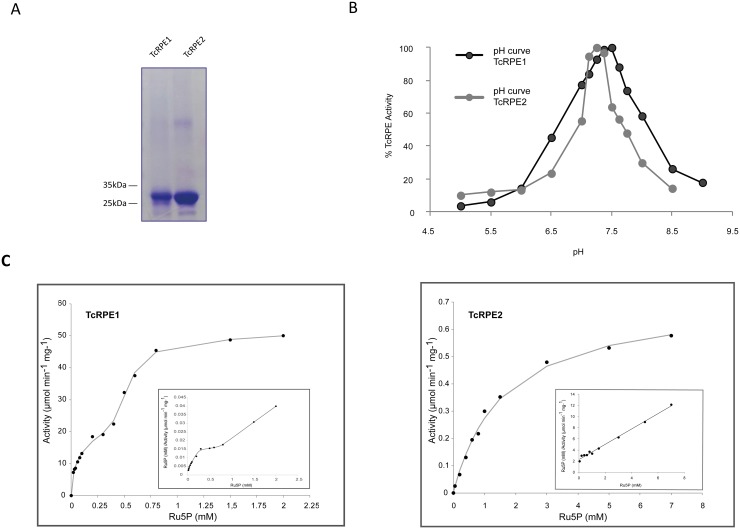
(A) Recombinant TcRPE1 and TcRPE2 preparations used for enzymatic assays. SDS-PAGE analysis followed by Coomassie Blue staining to assess the purity of the recombinant proteins TcRPE1 and TcRPE2. (B) Relative RPE activity as a function of pH for TcRPE1 and TcRPE2. Acetate, Bis-Tris, Tris-HCl buffer (50 mM each) was used over the complete pH range. Maximal activity was also observed at the same pH values if Tris-HCl or triethanolamine-HCl buffers were used instead. (C) Plot of RPE specific activity as a function of the concentration of the substrate Ru5P for TcRPE1 and TcRPE2. While TcRPE2 presents a typical hyperbolic response, TcRPE1 shows a very complex kinetic behavior to increasing concentrations of Ru5P. One of four independent experiments is shown as an example for each isoenzyme. The Hanes-Woolf plot is shown as an inset at the lower right of each panel. The experimental points shown are the mean of two determinations.